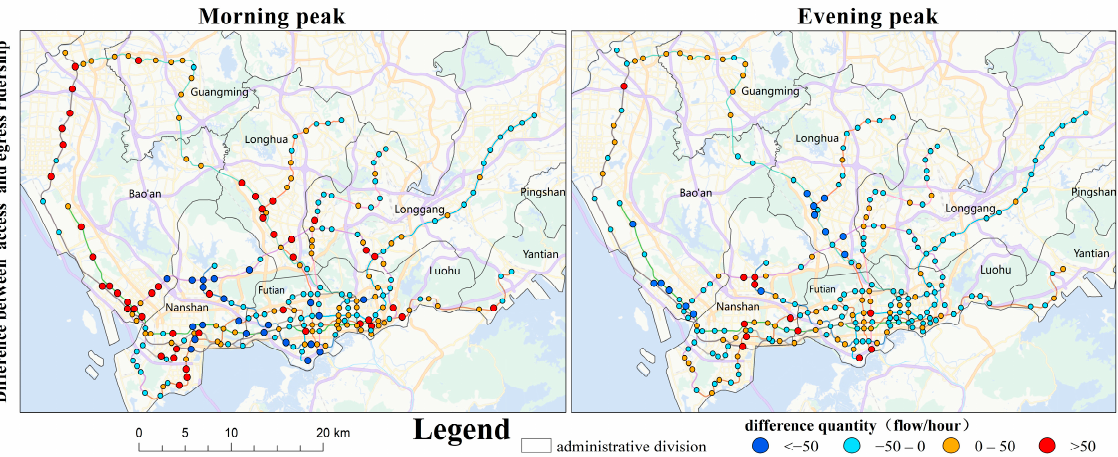
Figure 12. Spatial distribution of the difference in the amount of morning and evening peak integration cycling access use and egress use of each metro station on weekdays.